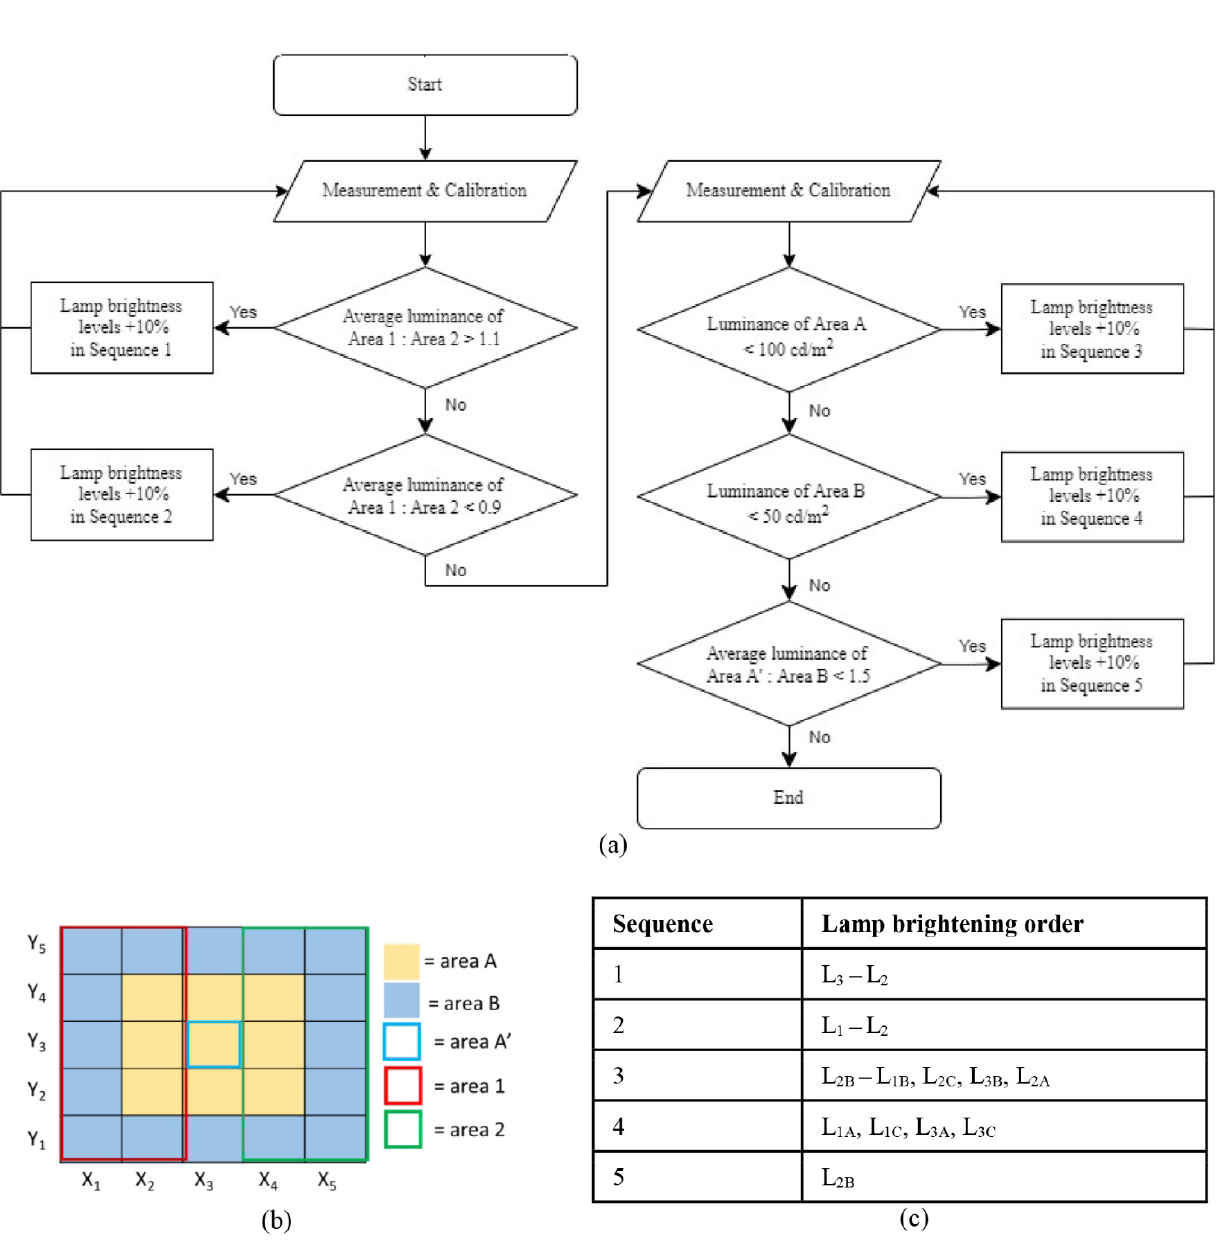
Figure 8. ( a ) The LCS flow diagram for scheme 3; ( b ) The layout of the room; ( c ) The sequence of the lamps brightened.